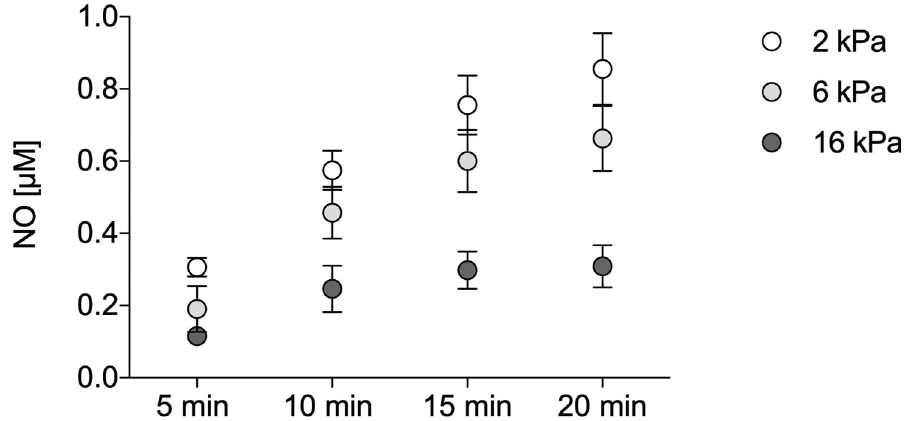
Fig 4. Average Nitric Oxide (NO) concentrations over time in cell- and tissue-free respiration medium containing 197 μ M spermineNONOate at three different pO electrode.